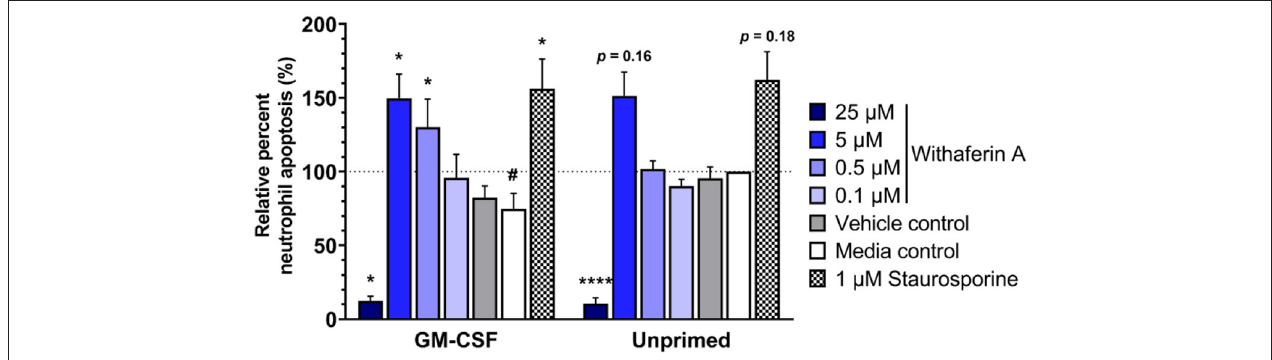
FIGURE 5 | Withaferin A promotes apoptosis of primed neutrophils by 24h. Mean (SEM) percentage of apoptotic neutrophils relative to media control, unprimed neutrophils following 24-h treatment of equine neutrophils under GM-CSF-primed or unprimed conditions ( n = 6 horses). Paired t -test of media control neutrophils; # p < 0.05 compared to unprimed media control. One-way repeated measures ANOVA (Holm-Sidak multiple comparison testing); * p < 0.05, **** p < 0.0001 compared to media control within same priming